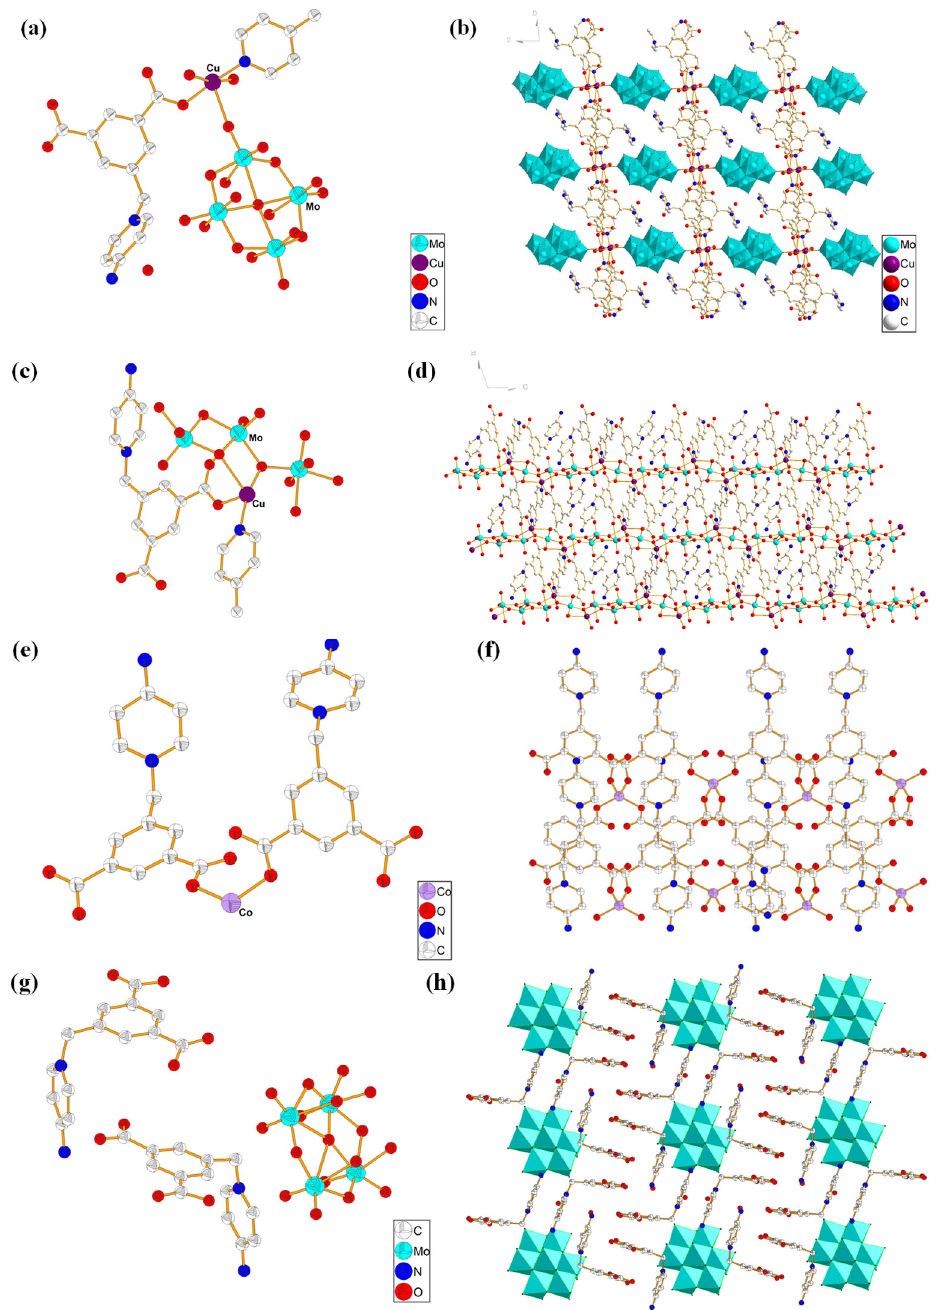
Figure 2. ( a ) Monomer structure diagram of compound 1 (with the H atom omitted), ( b ) Stacking diagram of compound 1 , ( c ) Structural unit diagram of compound 2 , ( d ) Stacking diagram of compound 2 , ( e ) Asymmetric structural unit diagram of compound 3 , ( f ) Stacking diagram of compound 3 , ( g ) Asymmetric structural unit diagram of compound 4 , ( h ) Stacking diagram of compound 4 .